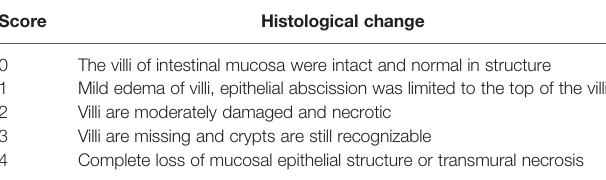
TABLE 1 | Evaluation scale of intestinal tissue